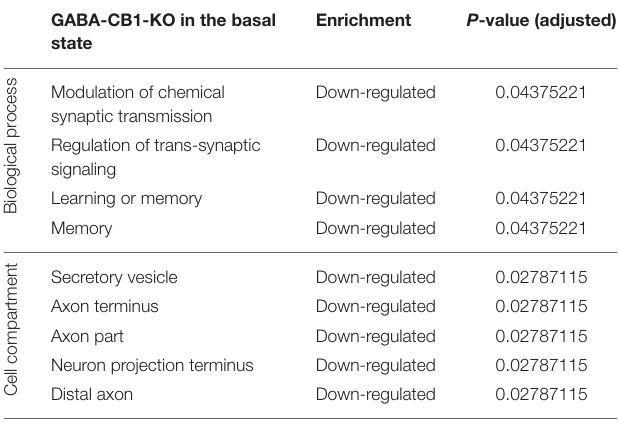
Table showing the list of GO terms resulting after analyzing the DEGs in the comparison GABA-CB1-KO vs. CB1-WT in the basal state. GO terms marked as downregulated indicate that these terms are enriched for downregulated DEGs, and the opposite holds true for terms marked as upregulated.